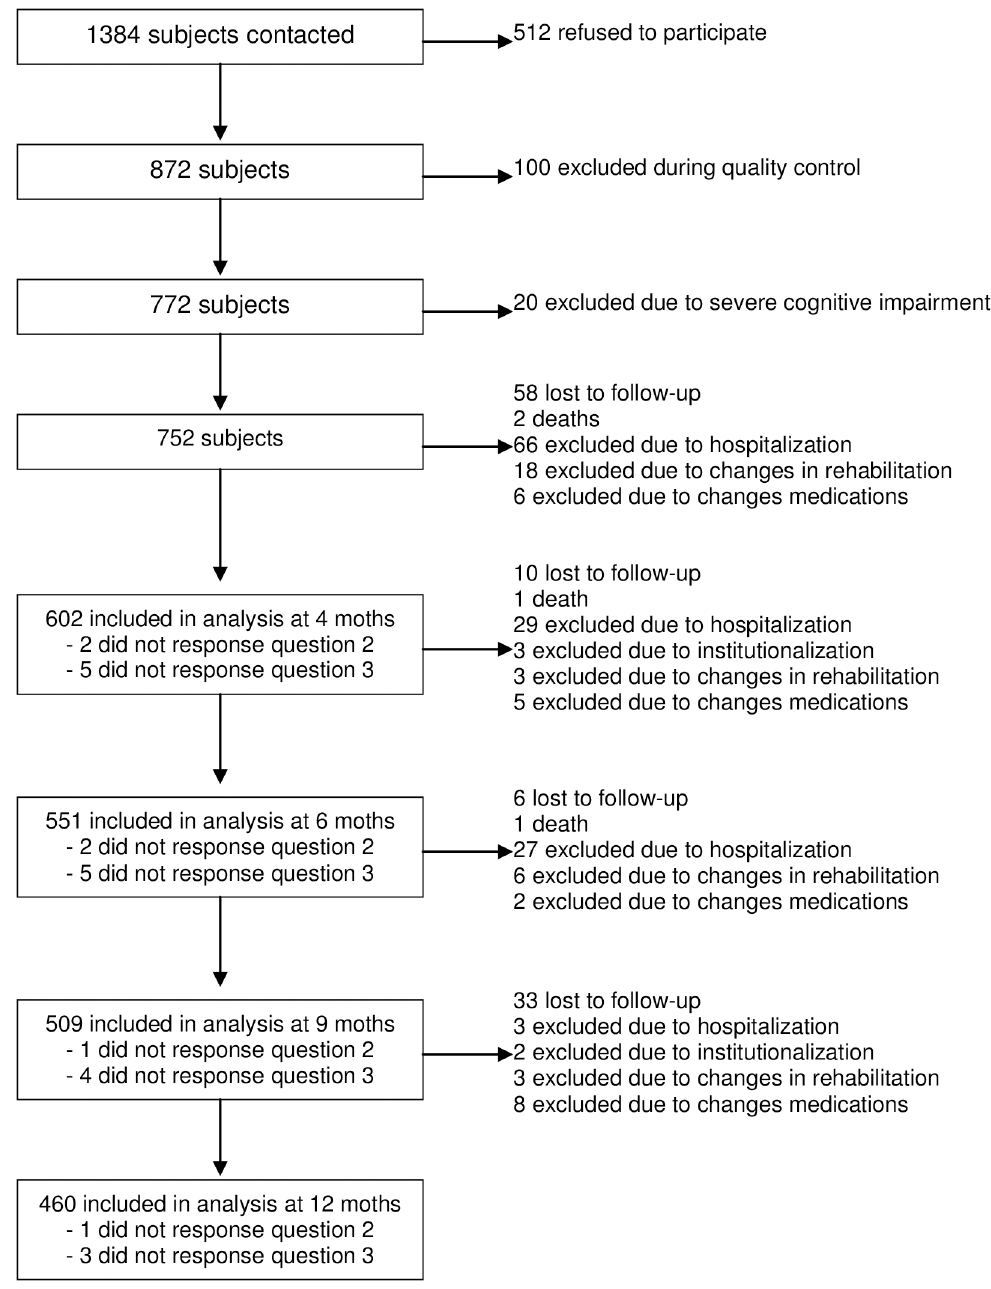
Fig 1. Subject exclusion and loss during the